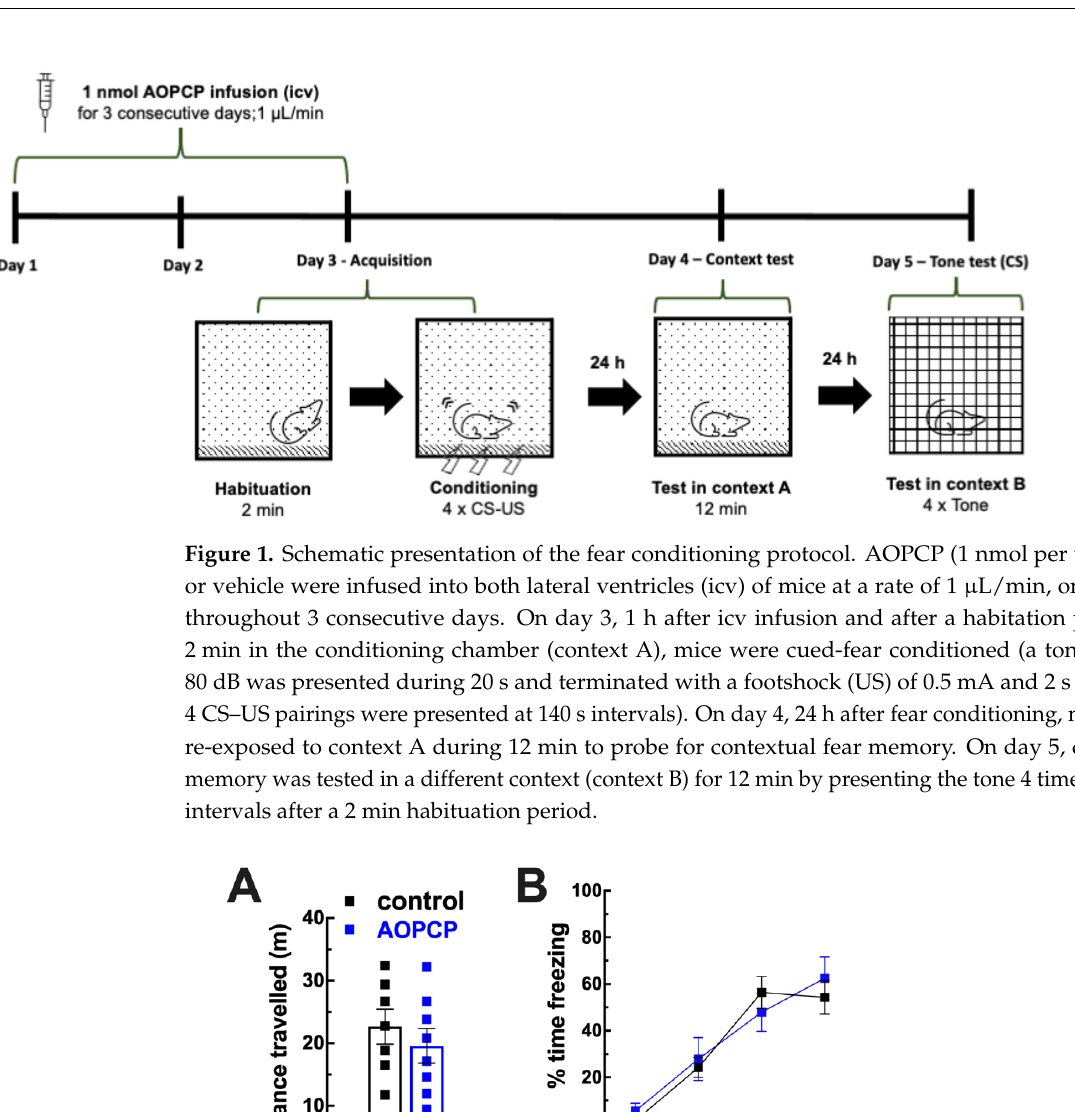
Figure 2. Pharmacological inhibition of CD73 before fear conditioning decreased contextual and cued fear memory in wild type mice. ( A ) Locomotor activity of AOPCP- and saline-treated wild type mice. The icv administration of AOPCP to CD73 wild-type (WT) mice (WT littermates of the CD73 knockout colony) did not change the locomotor profile compared to the control (saline- treated) group. ( B ) Fear conditioning of AOPCP-treated and saline-treated mice: freezing responses